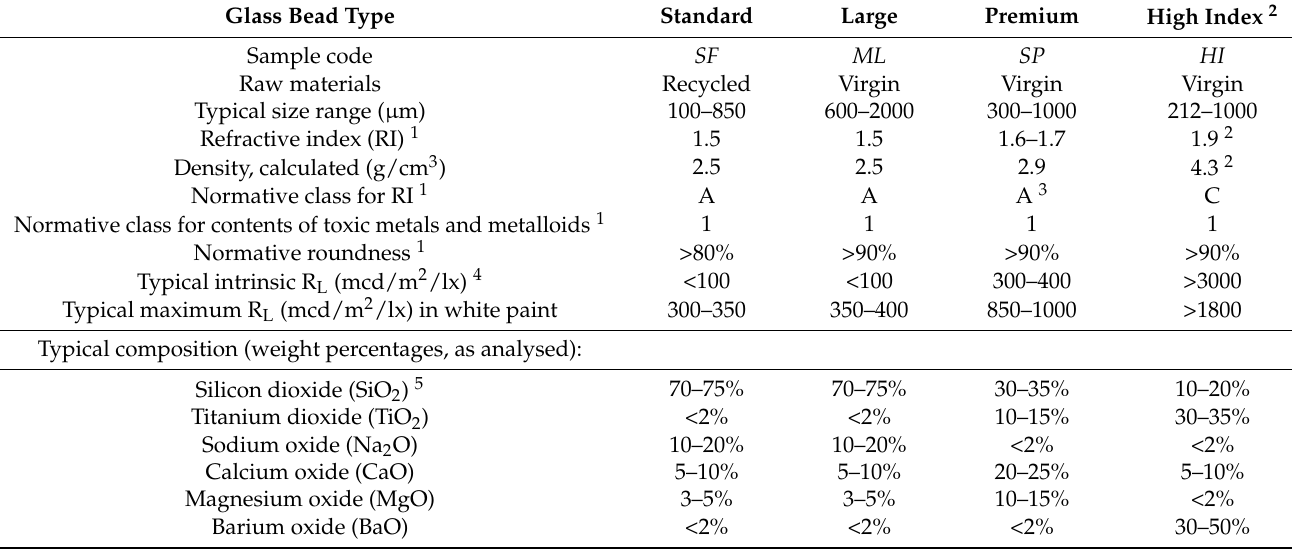
Table 1. Selected typical properties of glass beads for road